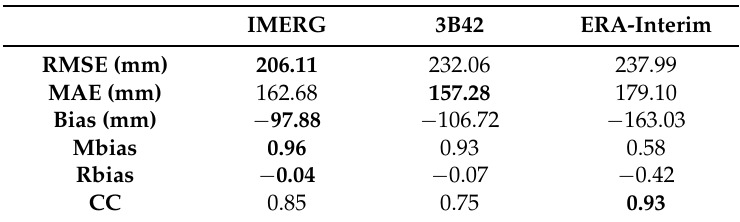
Table 12. Statistical indices of seasonal precipitation in Guilan area.